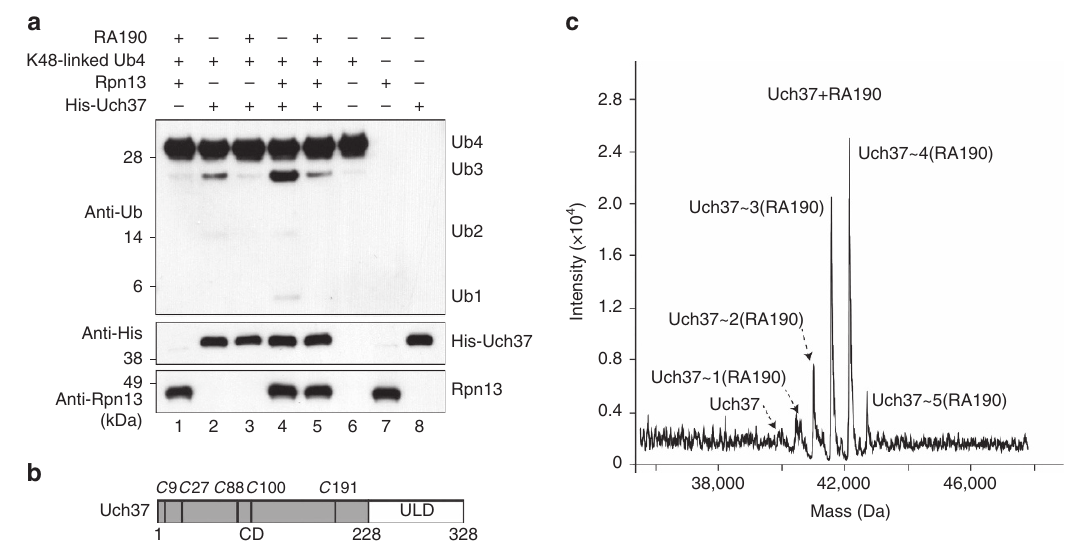
Figure 4 | RA190 binds Uch37 and inhibits its catalytic activity. ( a ) In vitro deconjugation assay of K48-linked tetraubiquitin (Ub4) by Uch37 with 20-fold molar excess RA190 and/or equimolar hRpn13, as indicated. Immunoprobing was performed as indicated. ( b ) Schematic representation of Uch37 depicting the catalytic domain (CD), hRpn13-binding region (Uch37-like domain (ULD)) and cysteines (italic ’ C ’ with numbers). ( c ) 2 m M purified Uch37 was incubated with 50 m M RA190 for 2h and samples subjected to LC-MS analysis to detect the formation of RA190 adducts. Table 4 | Detected Uch37 and hRpn13 species by LC-MS for indicated samples. Sample